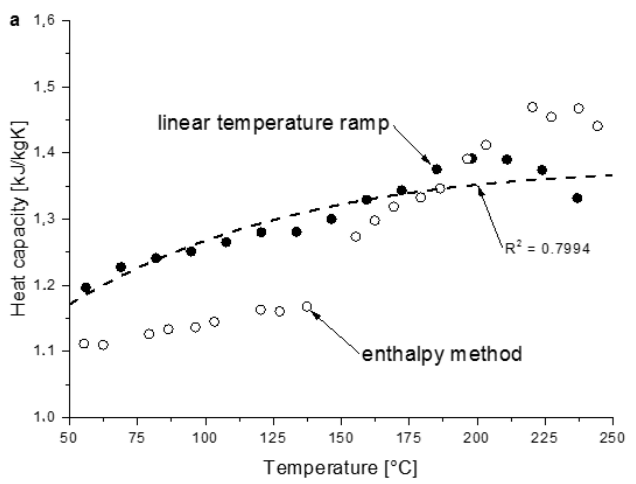
Figure 4. Graphs displaying c p , the specific heat capacity, vs. temperature. Both the data acquired Figure 4. using the “linear temperature ramp” with a rate of 5 °C min − 1 (full circles) and the “enthalpy method” (hollow circles) for 2 LiH + MgB 2 under Ar atmosphere ( a ); the data set plotted with other hydride values, for comparison ( b ).